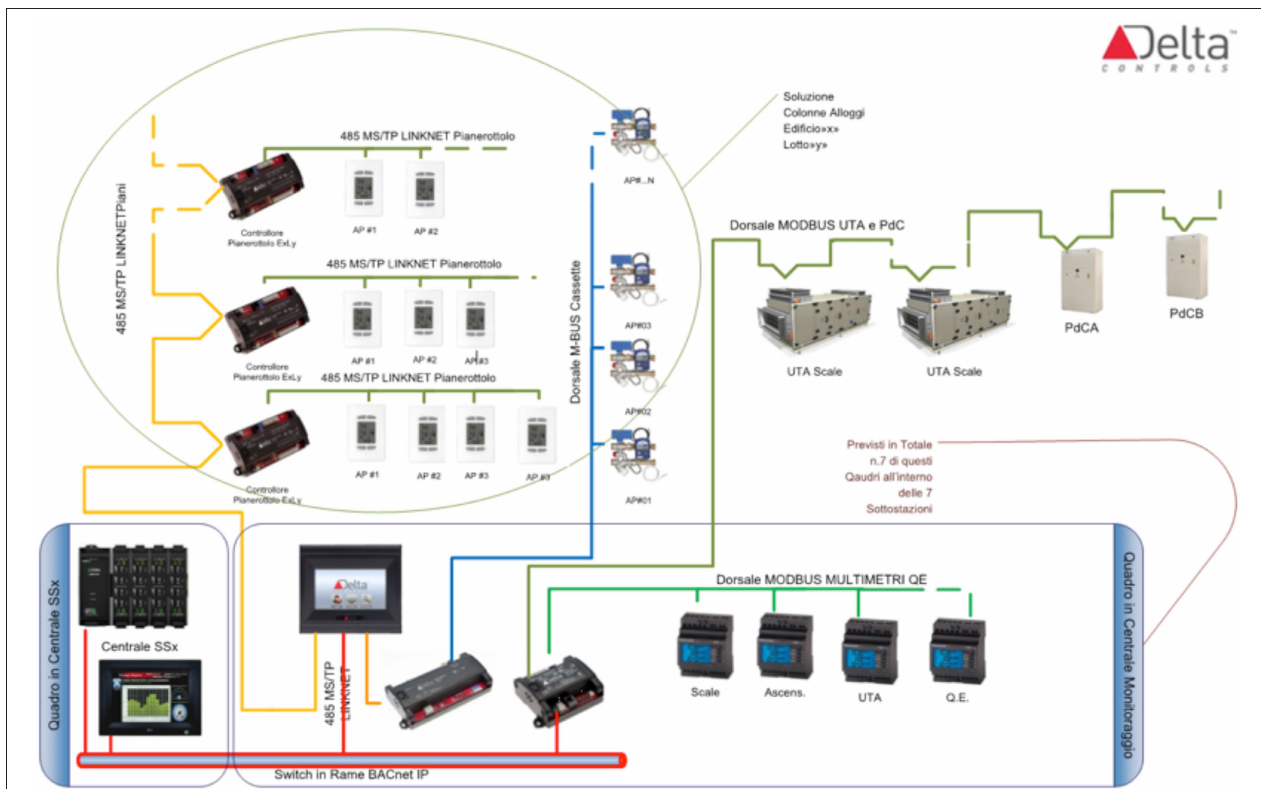
FIGURE 2 | Monitoring system architecture (courtesy of Delta Cotrols Italy